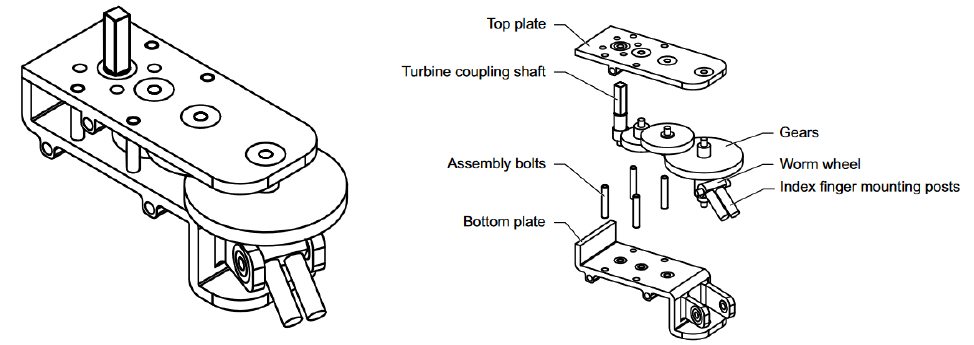
Figure 5. Schematic of the Modular Gearbox